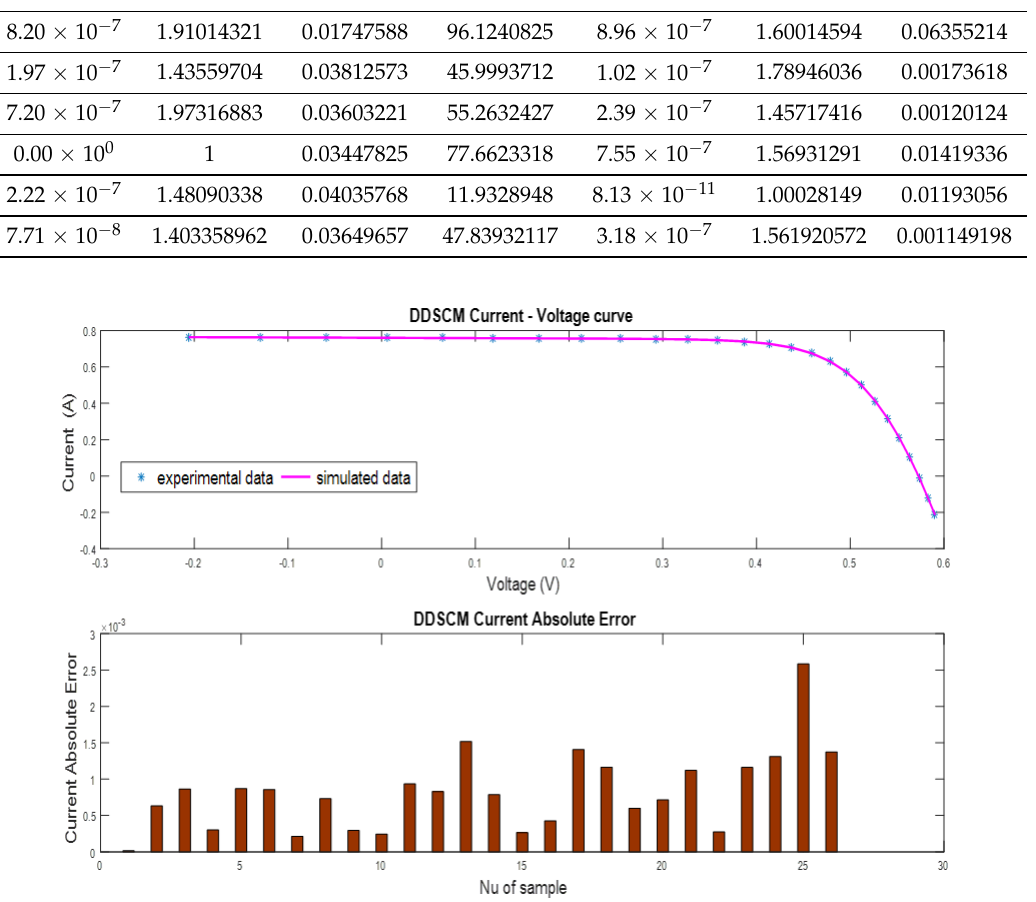
Figure 6. The I-V curve and current absolute error for